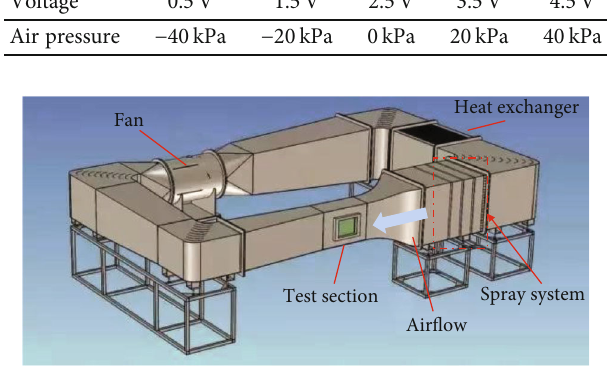
Figure 2: Icing wind tunnel ( 0 : 3 m × 0 : 2 m